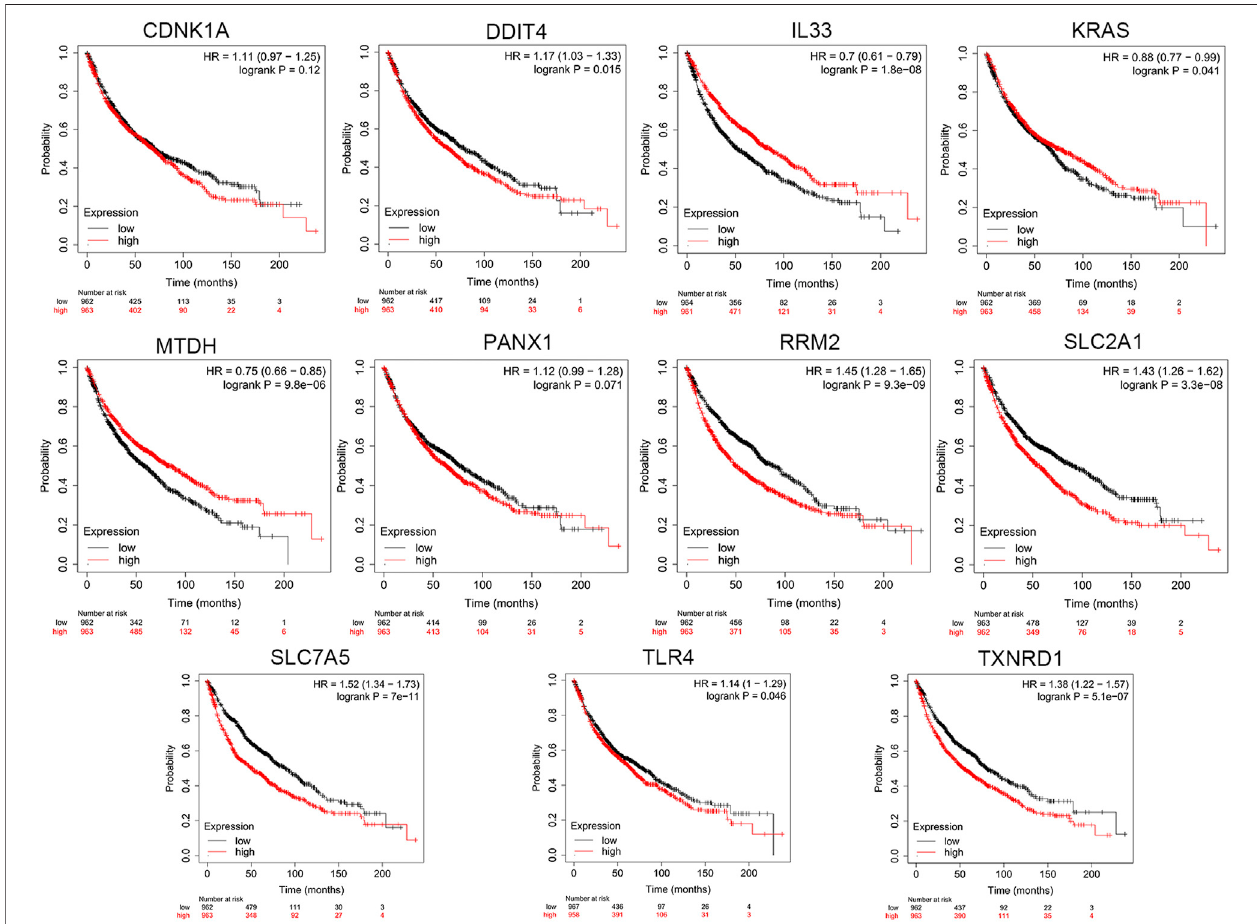
FIGURE 8 | The KM survival analysis between the high and low expressions of 11 ferroptosis-related genes in lung cancer in the online database.